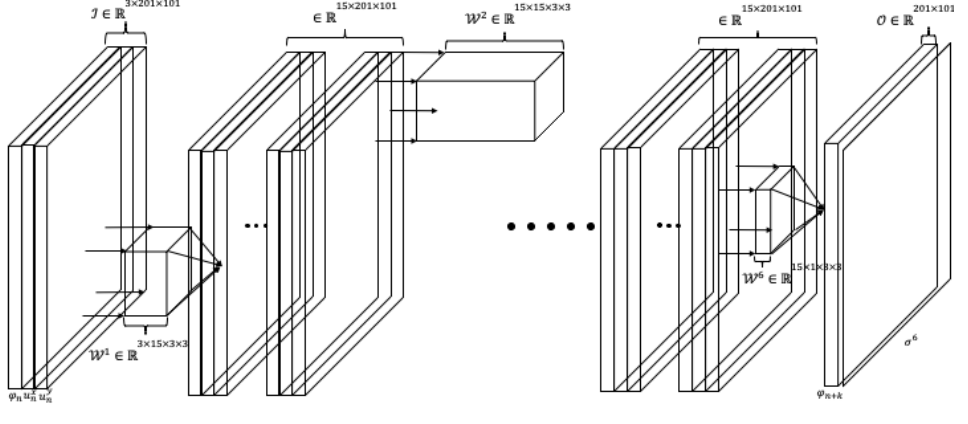
Figure 1. Visualisation of the TCNN from Example